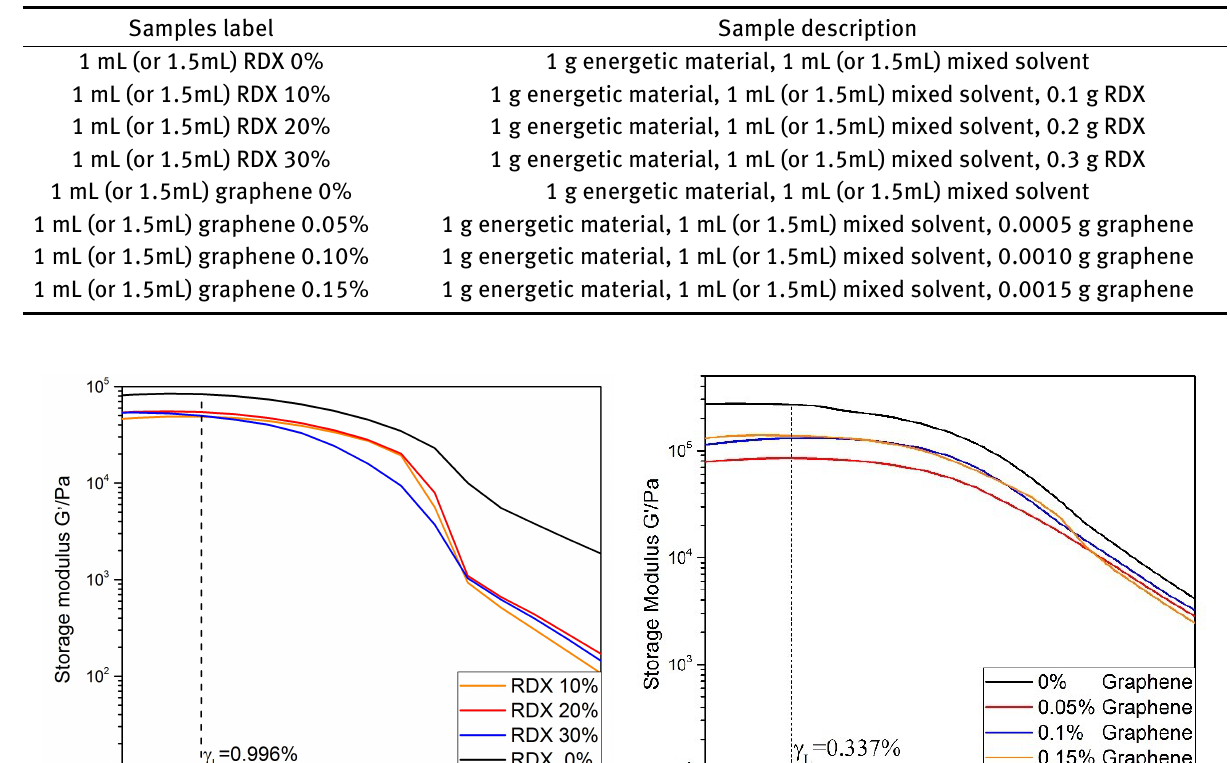
Table 1: Samples label and description